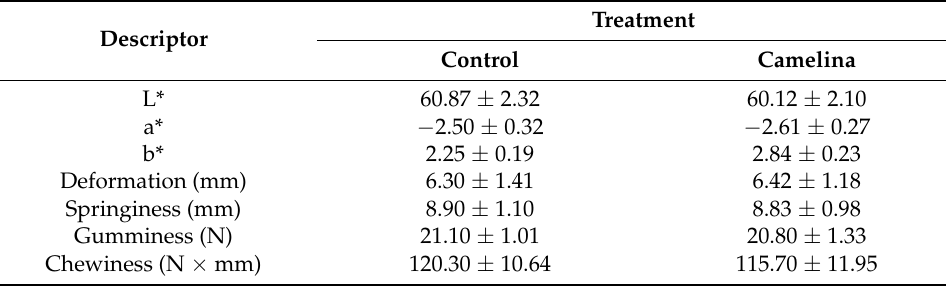
Table 4. Color evaluation and texture profile analysis of goat Caciotta cheese (mean ±